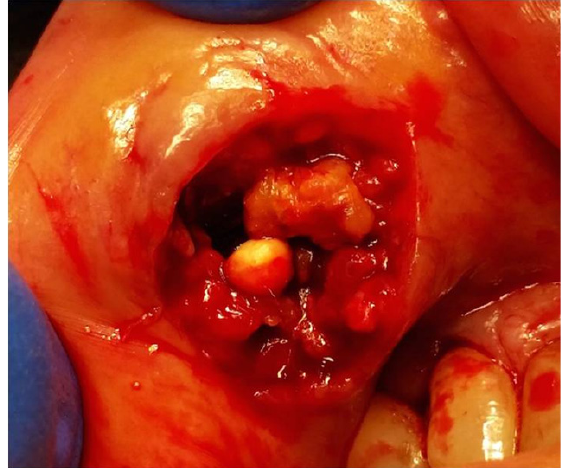
Figure 3: Ablative surgery of the lesion.